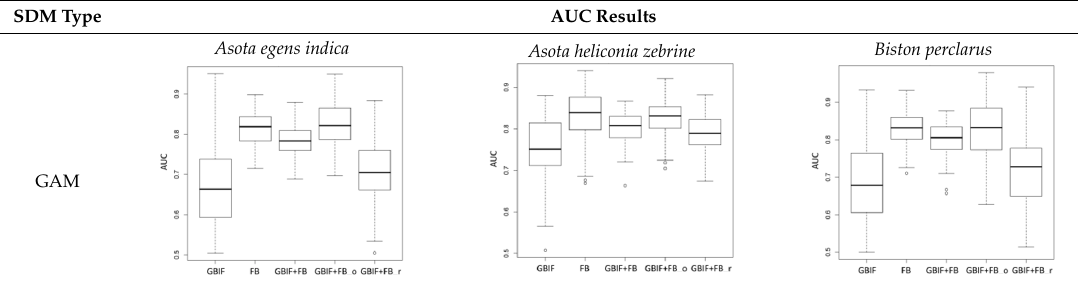
Table 4. Boxplots of the AUC values derived from four models (GAM, GLM, Maxent, and SVM) of five